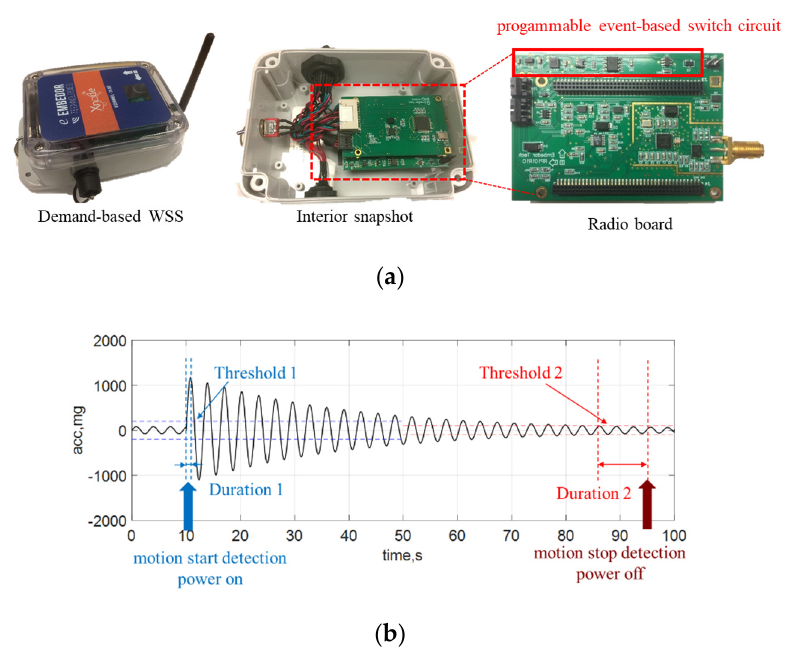
Figure 2. Demand-based WSS : ( a ) sensor prototypes, ( b ) illustration of event-triggered sensing.